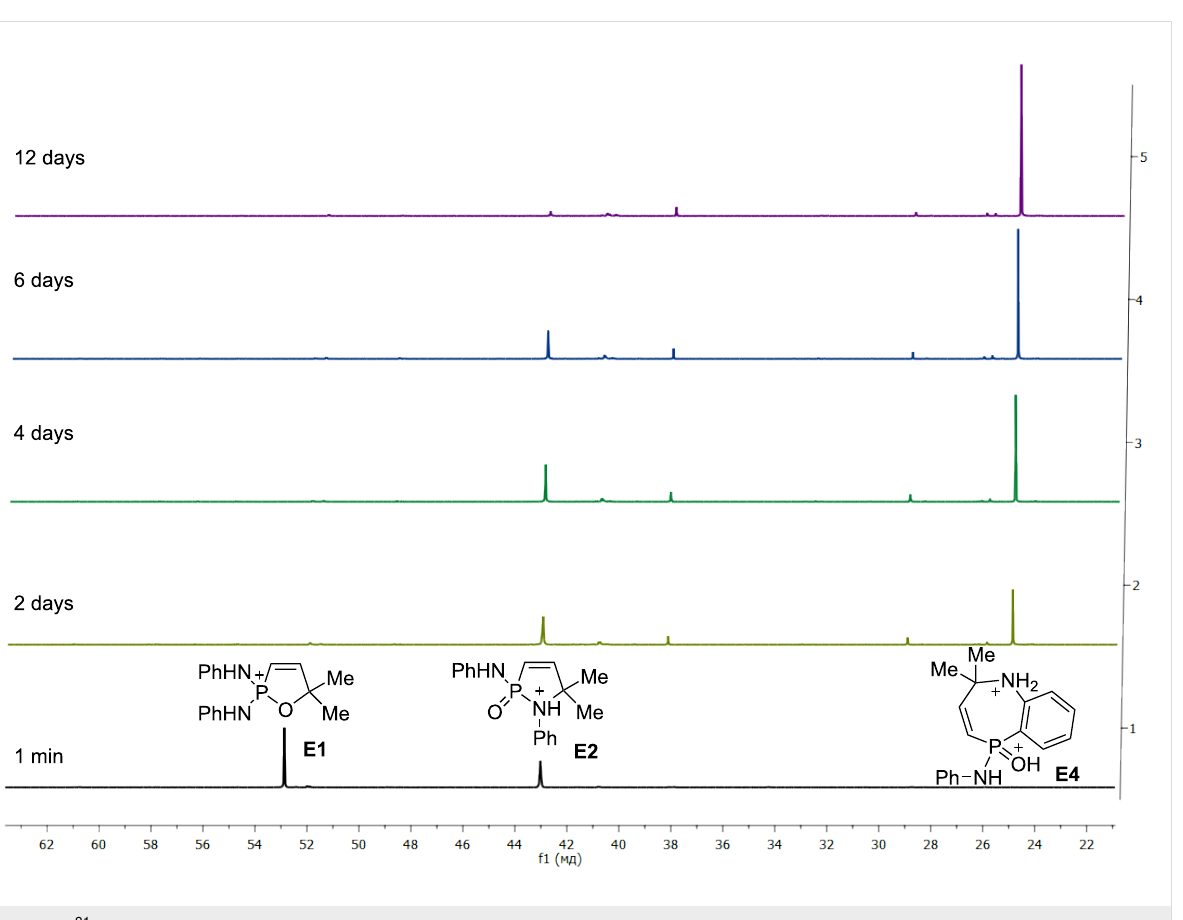
Figure 2: 31 P NMR monitoring of the progress of transformation of E1 into E2 and E4 in TfOH at room temperature.